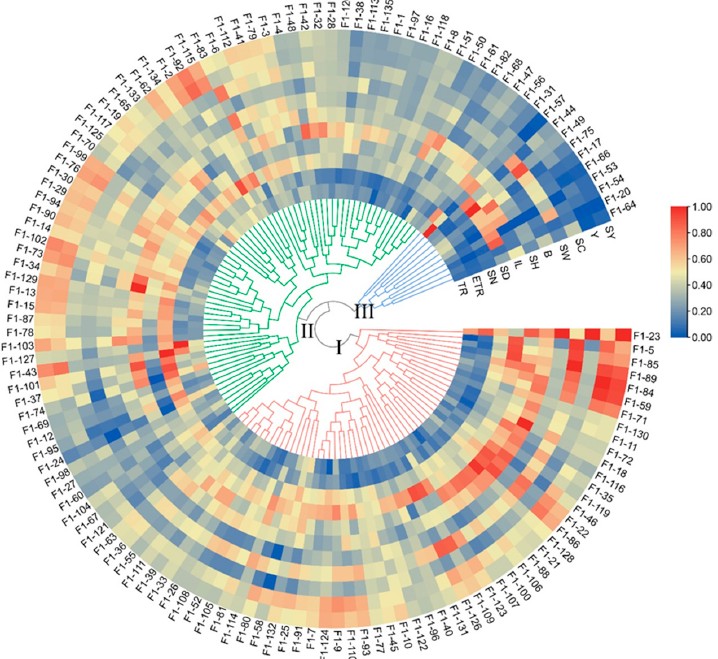
Figure 2. Cluster tree of the sugarcane F 1 population based on the 11 phenotypic traits. The cluster tree was generated using the standardized traits data through the Ward method. The heatmap of traits was built using the standardized data. TR, ETR, SN, SD, IL, SH, B, SW, SC, Y, and SY are the abbreviations of tillering ratio, effective tillering ratio, stalk number, stalk diameter, internode length, stalk height, Brix, stalk weight, sucrose content, yield, and sucrose yield, respectively. The 135 F 1 genotypes were divided into 3 groups (Group I-Group III), and the groups are indicated by green, blue, and red lines, respectively. Table 2. Variance explained by the first four PCs in the PCA of the F1 hybrid sugarcane population.